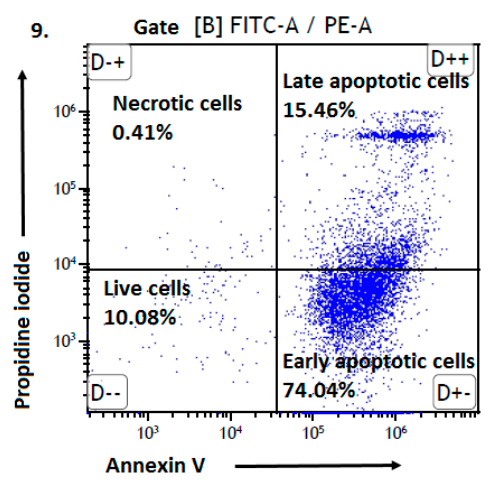
Figure 3. The effect of selected biguanides on AoSMC viability. ( I ) Representative (exemplary) cytograms of unstimulated AoSMCs (control). Cytogram 1. - Forward and side scatter plot of AoSMC control sample. The cells were marked with gate A. Cytogram 2.-A forward scatter width (FSC-W) vs. forward scatter area (FSC-A) of the cells gathered in gate A. Based on FSC-A parameters, single cells were divided, and marked with gate B. The single cells in gate B were analysed for staining with Annexin V and propidine iodide. Cytogram 3. - Annexin V (x-axis) vs propidium iodide (y-axis) plots from the gated cells (B) show the populations corresponding to living cells (Annexin V(-) and PI (-)) (gate D- - on cytogram); early apoptotic cells (Annexin V (+) and PI (-)) (gate D+- on cytogram), late- apoptotic cells (Annexin V(+) and PI (+)) (gate D++ on cytogram), and necrotic cells (Annexin V (-) and PI (+)) (gate D-+ on cytogram). ( II ) Representative (exemplary) cytograms of AoSMCs stimulated with metformin at the concentration of 1.5 μ mol/mL. Cytogram 4. - Forward and side scatter plot of AoSMC cells stimulated with metformin. The cells were marked with gate A. Cytogram 5.-A forward scatter width (FSC-W) vs. forward scatter area (FSC-A) of the cells gathered in gate A. The single cells in gate B were analysed for staining with Annexin V and propidine iodide. Cytogram 6. - Annexin V (x-axis) vs propidium iodide (y-axis) plots from the gated cells (B) show the populations corresponding to living cells (gate D—on cytogram); early apoptotic cells (gate D+- on cytogram), late-apoptotic cells (gate D++ on cytogram) and necrotic cells (gate D-+ on cytogram). ( III ) Representative cytograms of AoSMCs treated with compound 1 at a concentration of 0.9 μ mol/mL. Cytogram 7. - Forward and side scatter plot of AoSMC cells treated with compound 1 . The cells were marked with gate A. Cytogram 8. - A forward scatter width (FSC-W) vs. forward scatter area (FSC-A) of the cells gathered in gate A. The single cells in gate B were analysed for staining with Annexin V and propidine iodide. Cytogram 9.- Annexin V FITC-A (x-axis) vs PI (y-axis) plots from the gated cells (B) show the populations corresponding to living cells (gate D—on cytogram), early apoptotic cells (gate D+- on cytogram), late- apoptotic cells (gate D++ on cytogram) and necrotic cells (gate D-+ on cytogram).